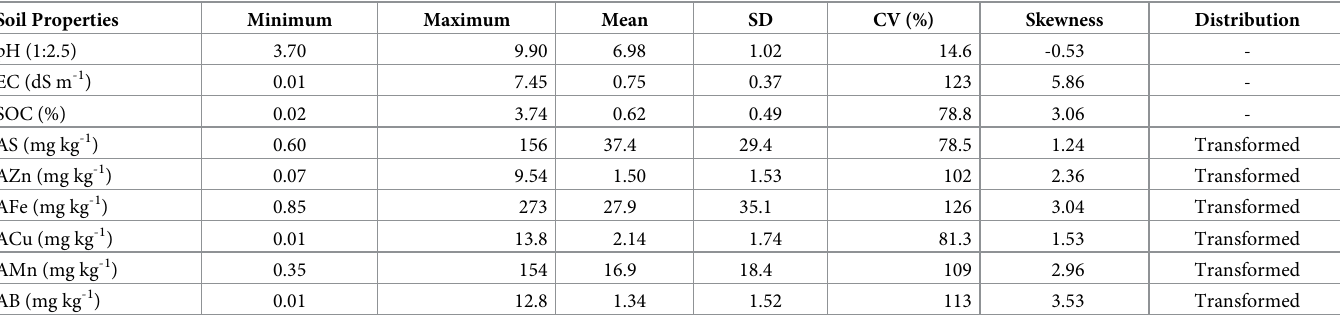
Table 2. Descriptive statistics of soil parameters of cultivated areas of coastal India. Soil Properties